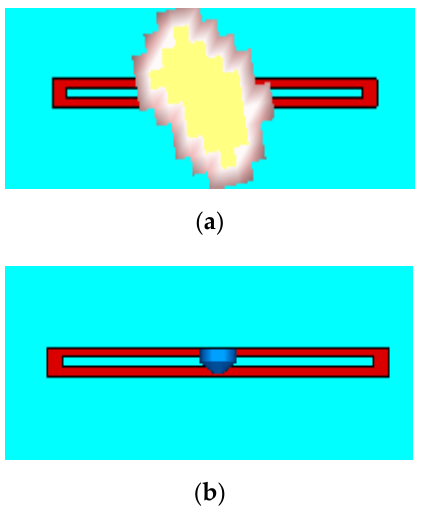
Figure 8. Simulation Structure corresponding to: ( a ) finger touch (only the fingertip was considered in the simulation); ( b ) lumped capacitor in loop structure.